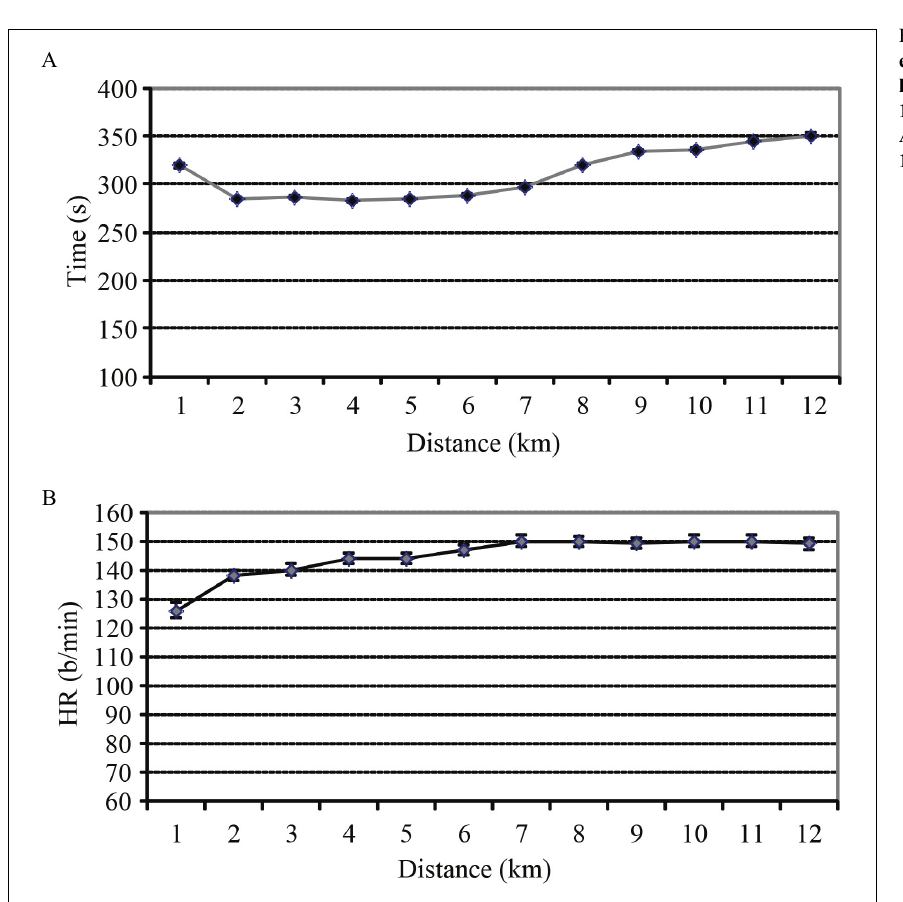
Figure 3. Indices characterizing external and internal physical loads during the task “run 12 km at a steady